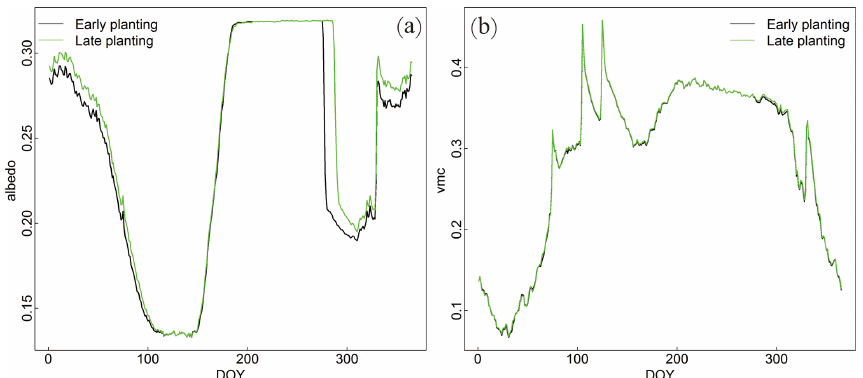
Figure 5. Dynamics of (a) surface albedo and (b) surface soil moisture content under two sowing scenarios in the winter wheat growing season.